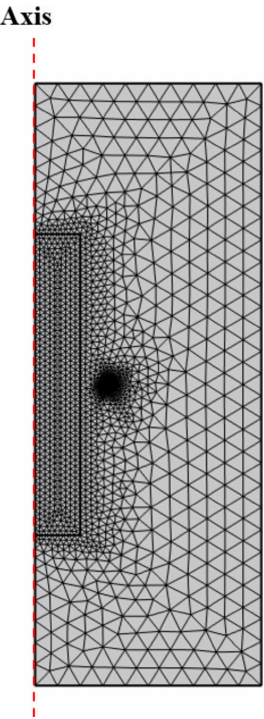
Figure 2. Zone refining reactor meshing.